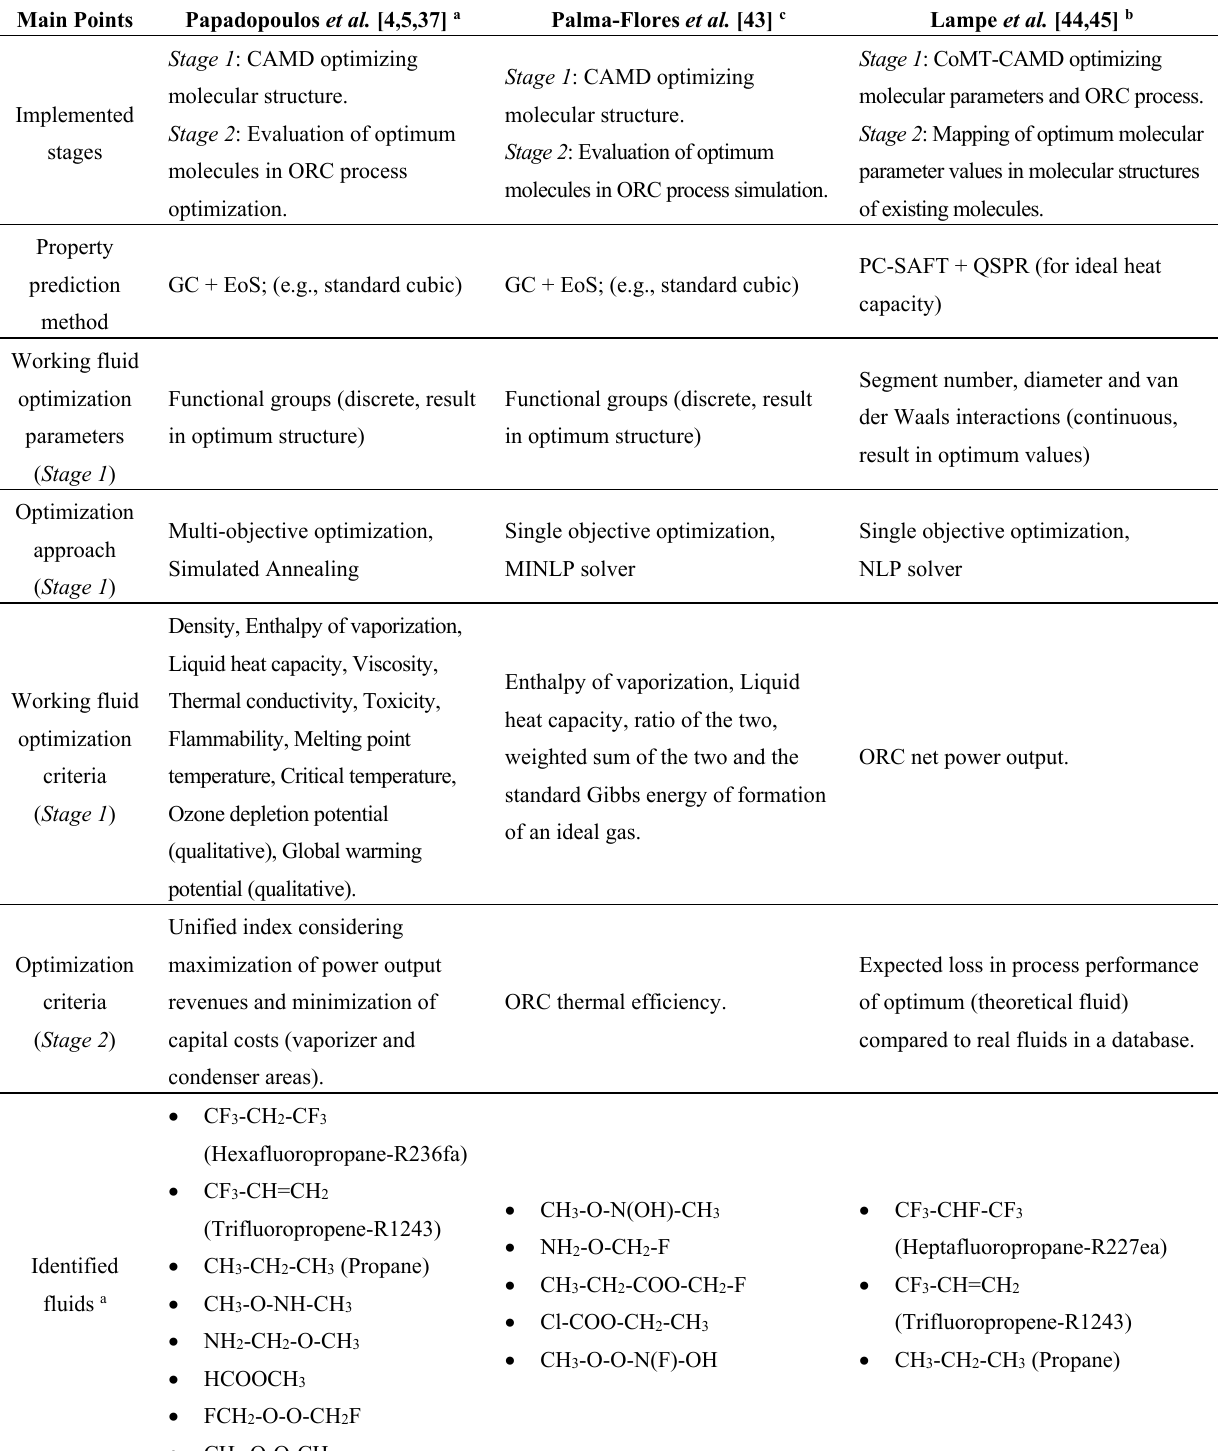
Table 1. Main points in existing methods for the optimum design of pure ORC working fluids. Main Points